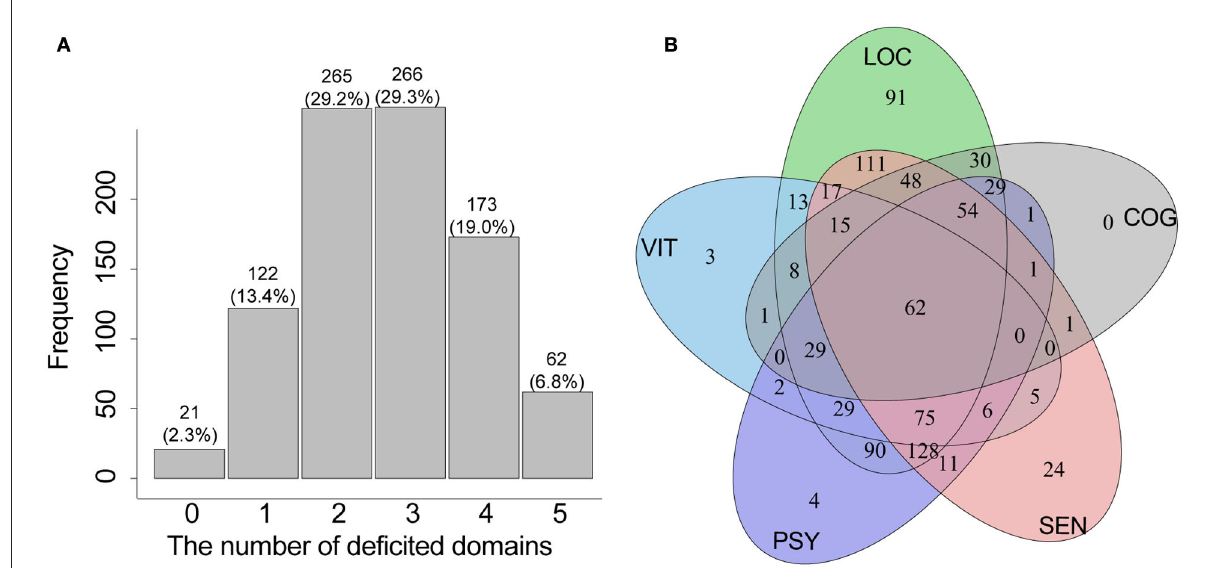
FIGURE1 The distribution (A) and overlap (B) of the IC domains among older inpatients. IC, intrinsic capacity; LOC, locomotion domain; SEN, sensory domain; PSY, psychological domain; COG, cognition domain; VIT, vitality